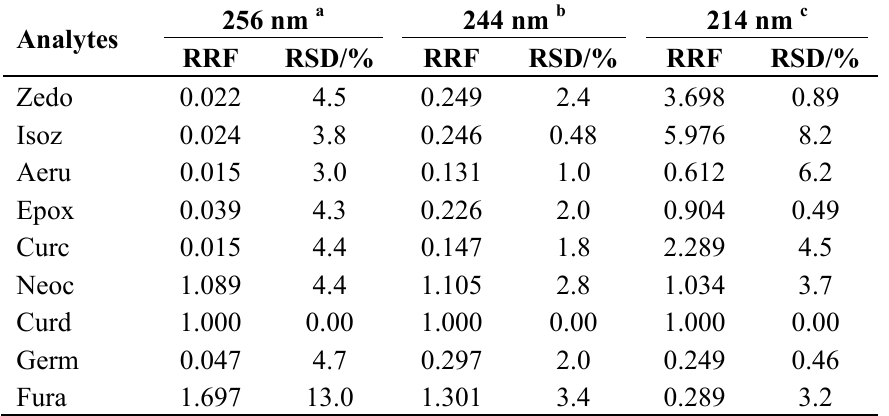
Table 3. The relative response factors (RRFs) for sesquiterpene standards against curdione.